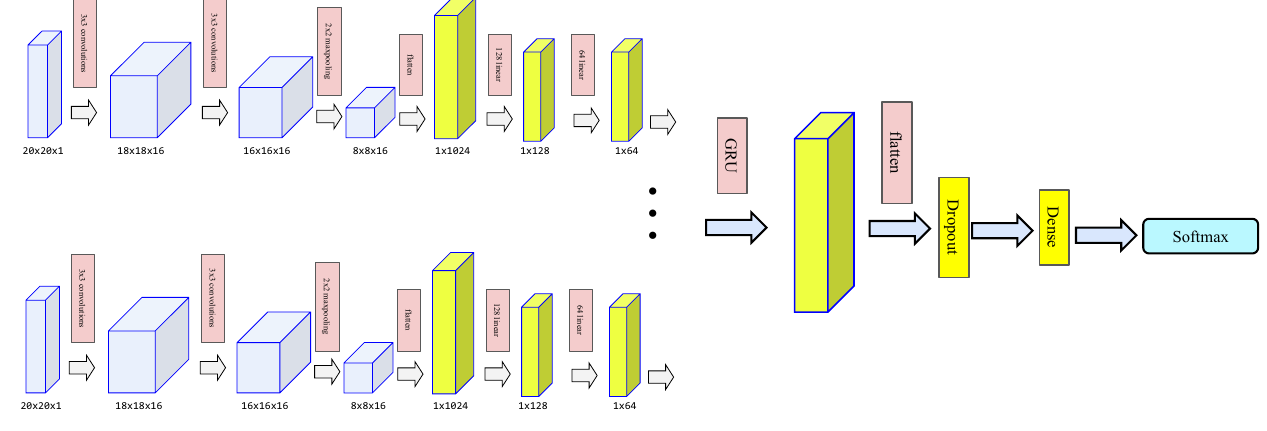
Figure 5. Local model